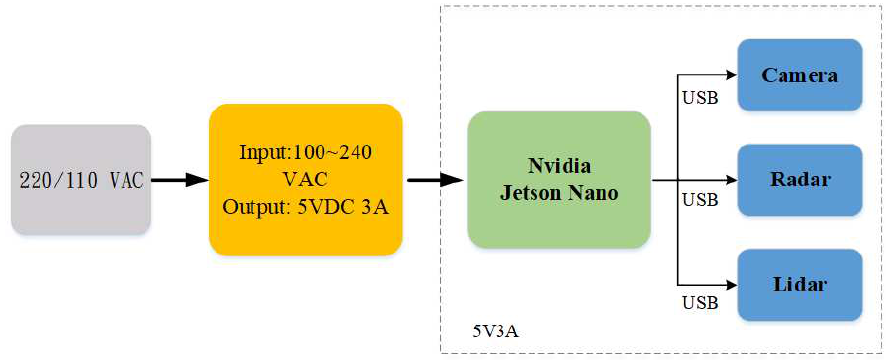
Figure 7. Parking meter data collector on NVIDIA Jetson